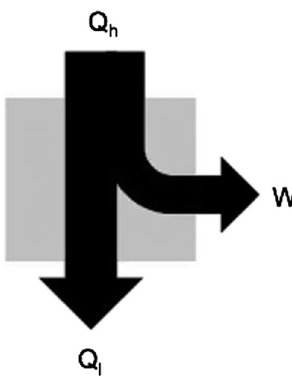
FIG. 3. Energy flow diagram for any continuously operating reversible device generating work from heat.